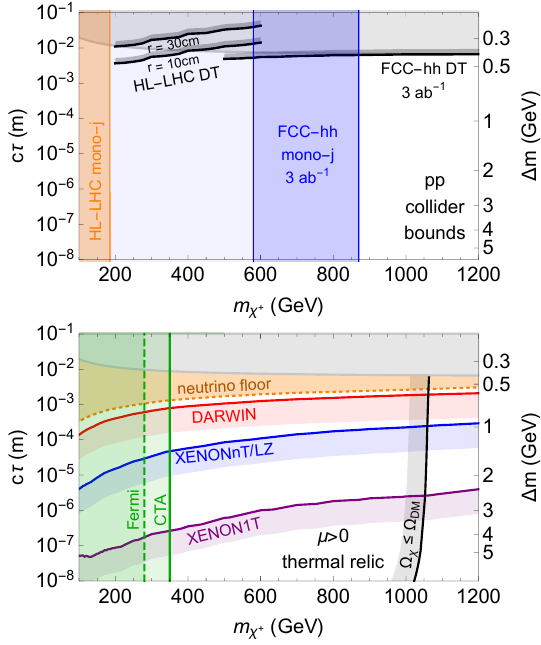
Figure 3 . Projected Higgsino bounds from future pp colliders (top) and cosmology (bottom). Top: vertical bands indicate the approximate projected mass reach of monojet searches, with darker shading indicating the dependence of reach on the assumed systematic error. Regions above black contours can be excluded by disappearing track searches [91] at the HL-LHC (optimistic and pessimistic) and FCC-hh. See text for details. Bottom : Longer lifetimes indicate smaller direct detection signal, hence the bounds from XENON1T [120], XENONnT [120]/LZ [121] and DARWIN [122] are sensitive to the region below the colored contours. The orange region lies below the neutrino (cid:13)oor for direct detection. Also shown is the approximate mass exclusion of Fermi (existing) and CTA (projected). The black line indicates the maximum mass for the Higgsinos such that their relic abundance is at most (cid:10) DM . The (cid:22) < 0 case is nearly identical. Relic density and direct detection bounds are taken from [123]. Grey upper region indicates lifetimes corresponding to smaller mass splittings than the minimal electroweak